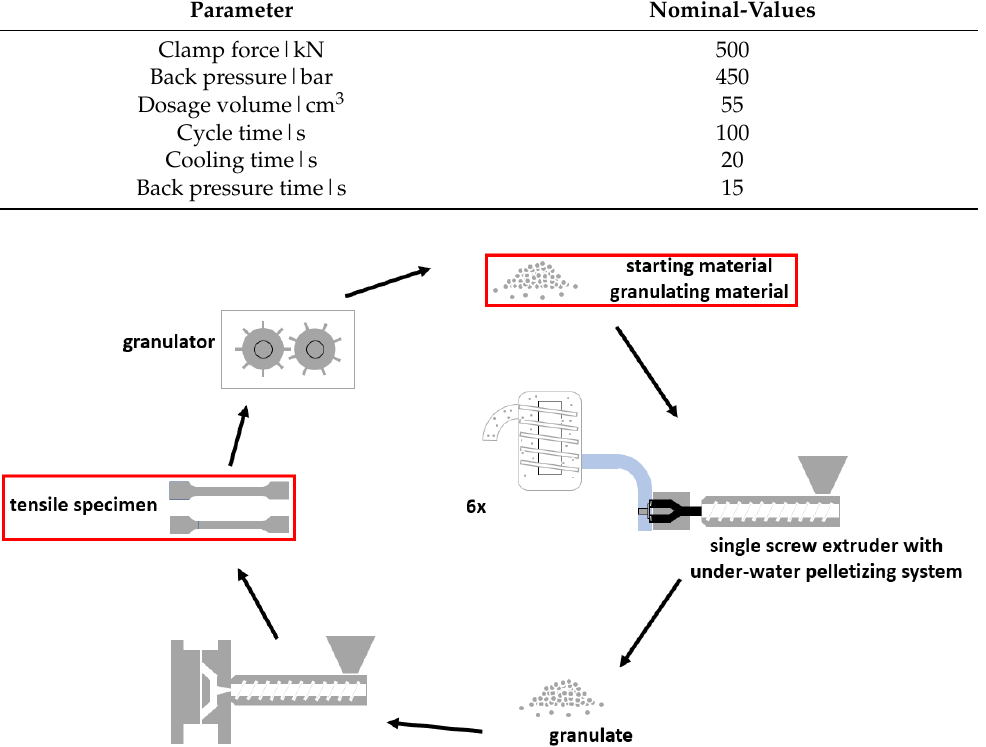
Figure 3. Schematic representation of the extrusion-injection molding cycle (CL-EI) using a 35/34D single screw extruder with an EUP 50 under-water pelletizing system, an injection molding machine victory 60, and granulator S-Max 2 Plus.